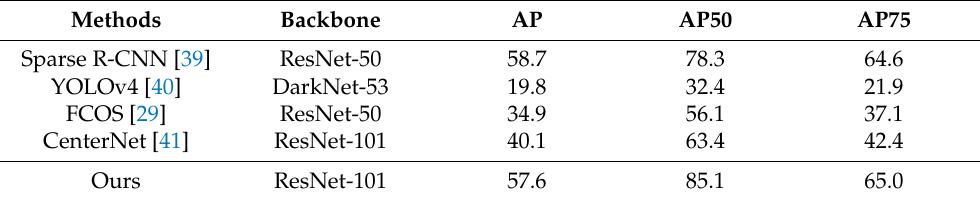
Table 2. Comparison of AP, AP50, and AP75 results for the MammData dataset.